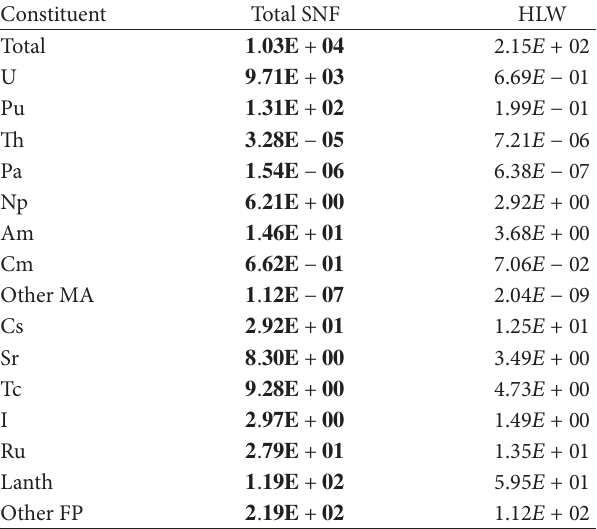
T 1: Inventories (tonnes) of the German SNF and HLW in